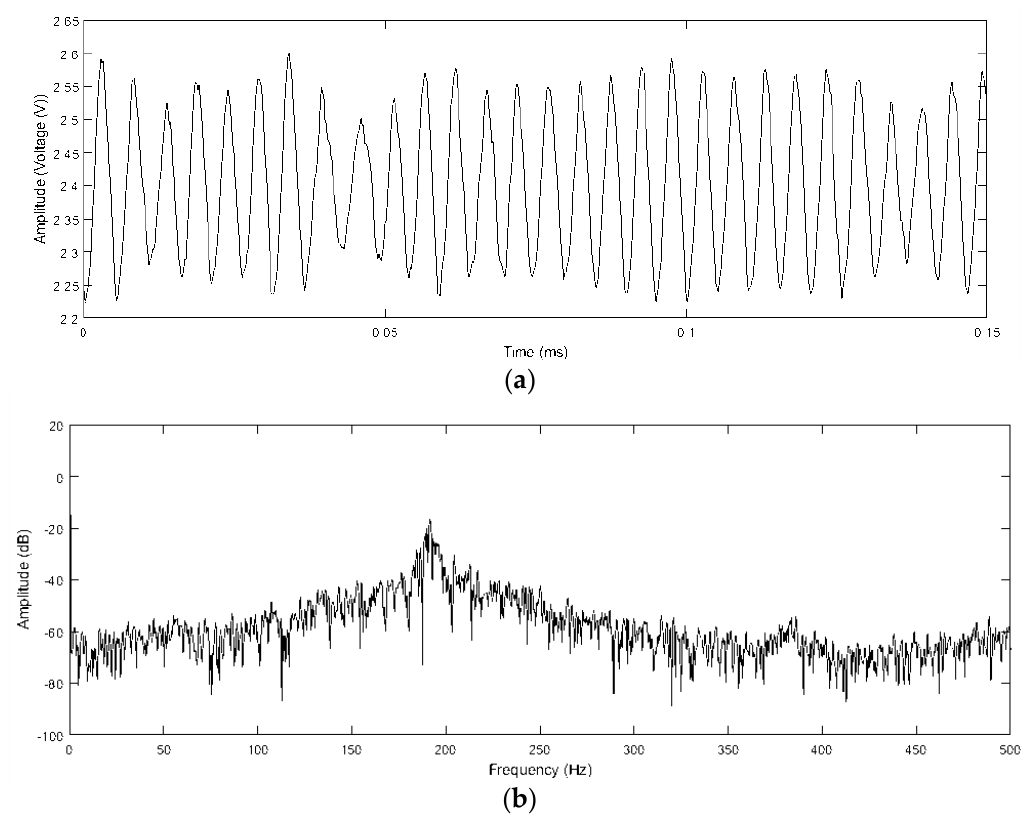
Figure 5. An exemple of a raw waveform from a fluidic oscillator ( a ) and its translation in frequency domain post FFT ( b ). Aliasing effects of FFT are mitigated by having a high acquisition rate (512 kHz with 512 k samples acquisition window).